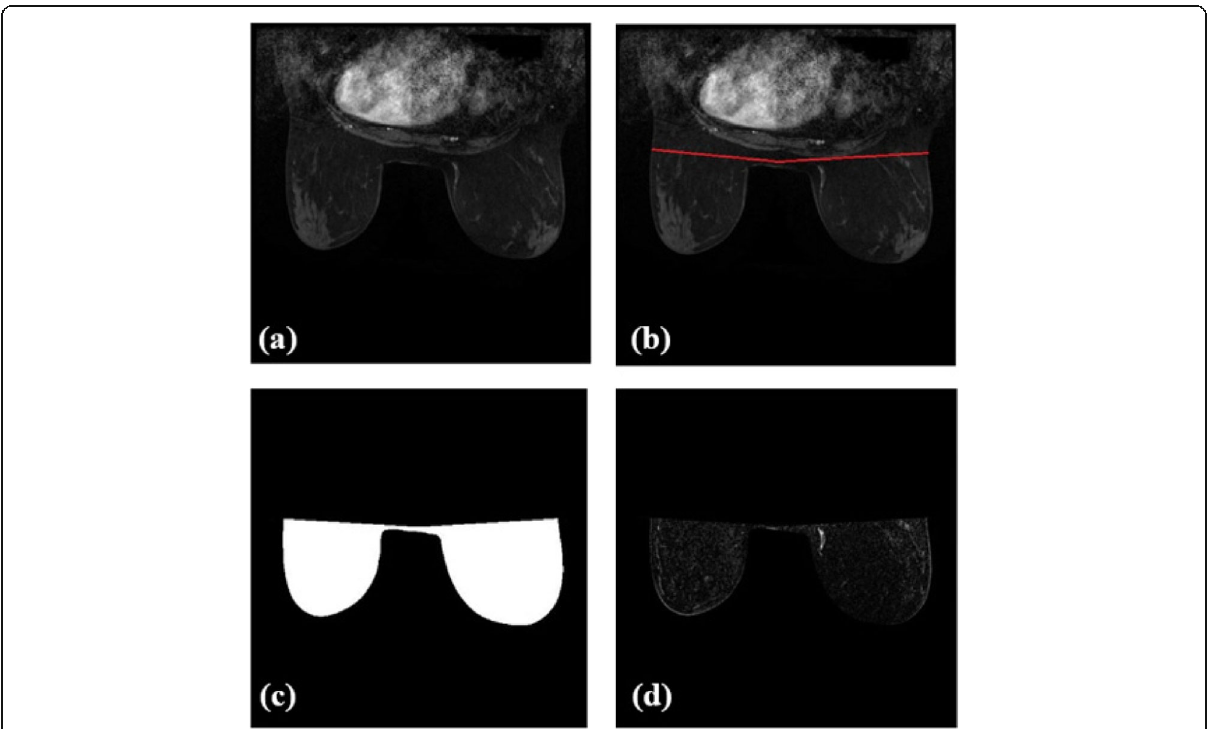
Fig. 4 Breast region segmentation steps and generating the contrast-enhanced image map including ( a ) the original image, ( b ) separation line, ( c ) generated mask, and ( d ) breast region segmented on the contrast-enhanced